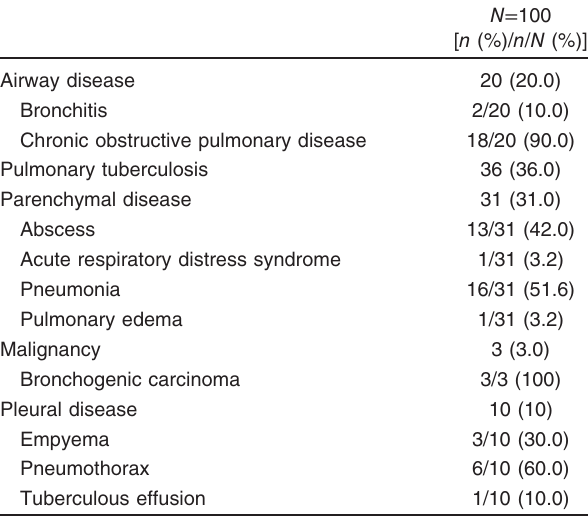
Table 2 Description of the pulmonary complications of the studied patient